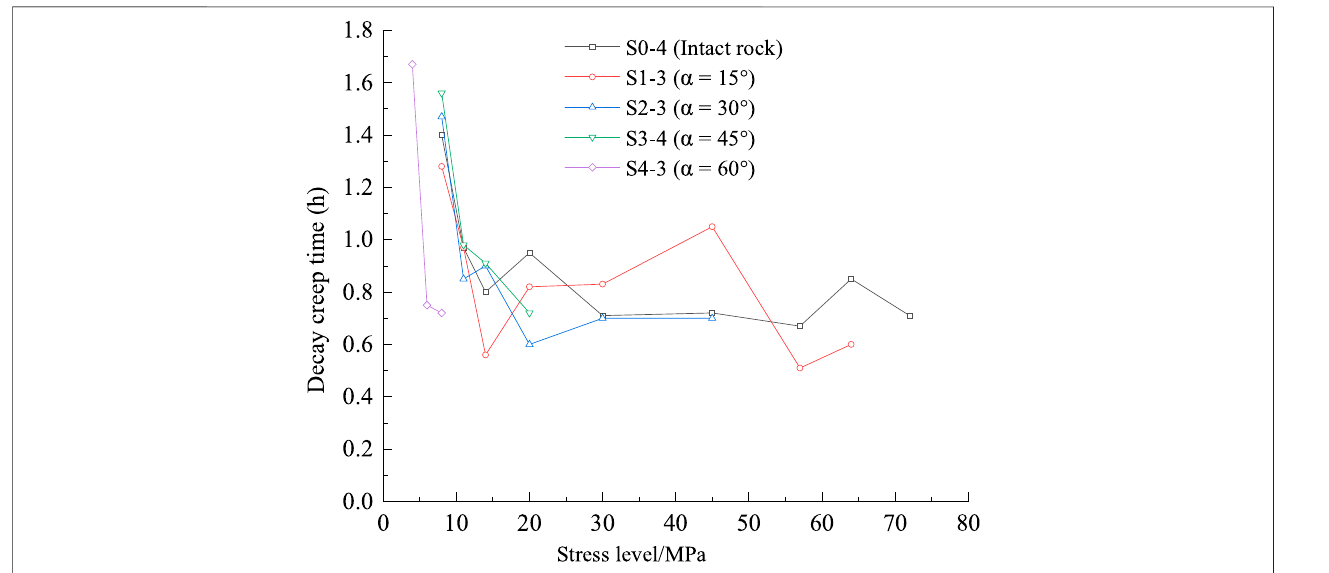
FIGURE 9 | Decay creep time – stress curves of specimens from the fi rst to the last stress levels.